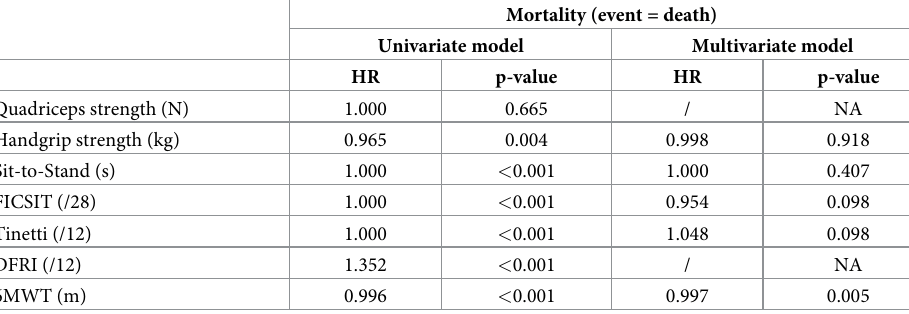
Table 2. Unadjusted competing risks regression model for mortality.